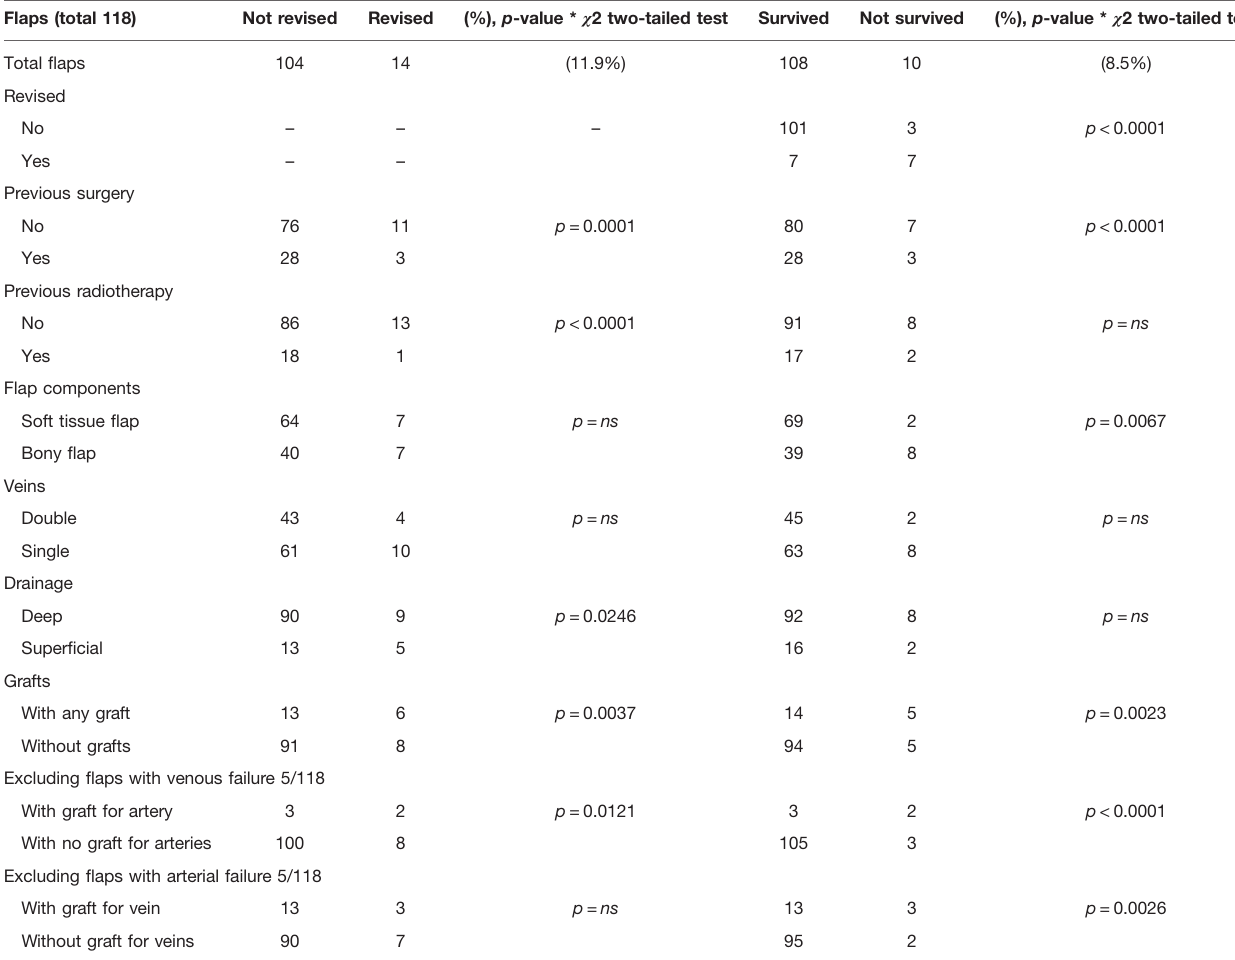
TABLE 3 | Summary of variables analyzed for fl ap revision and fl ap survival. Flaps (total